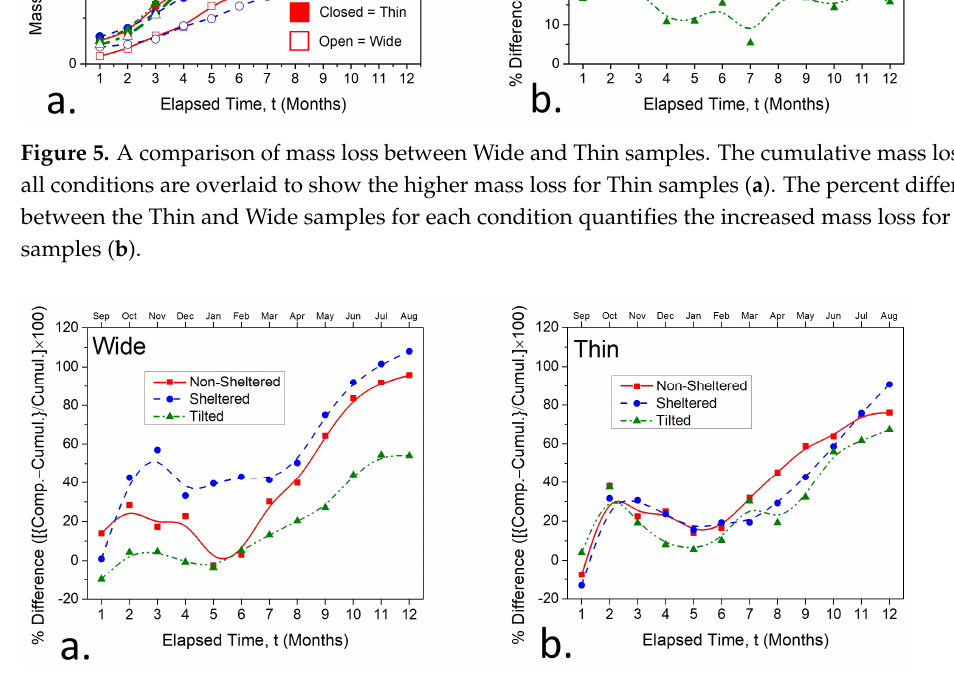
Figure 6. The percent difference in mass loss density values observed between the monthly compo- site and cumulative exposure times for the Wide ( a ) and Thin ( b )